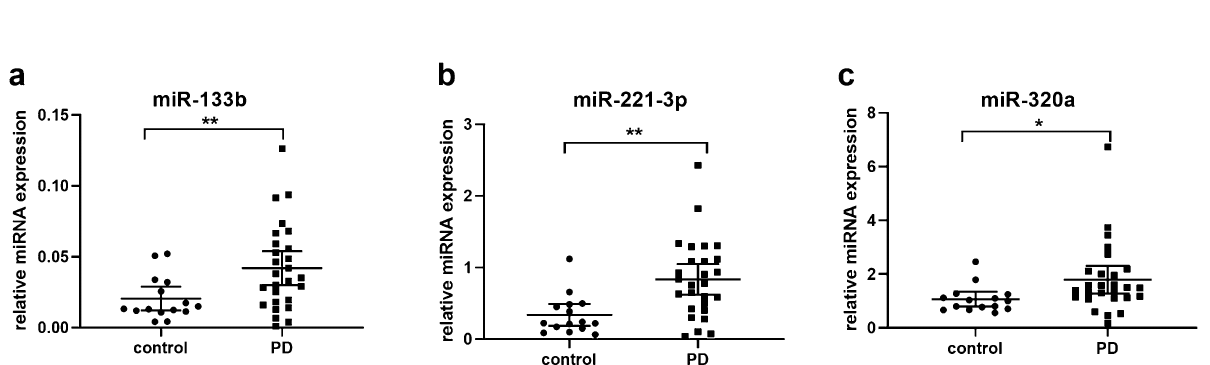
Figure 2. Plasma miR-133b ( a ), miR-221-3p ( b ) and miR-320a ( c ) expression in patients with PD (n = 27) and healthy controls (n = 15) from cohort 2. An independent t test was used to evaluate differences between groups. Data are presented as the means ± SEMs. The results are indicated as ** p value < 0.01 and * p value < 0.05. PD, Parkinson’s